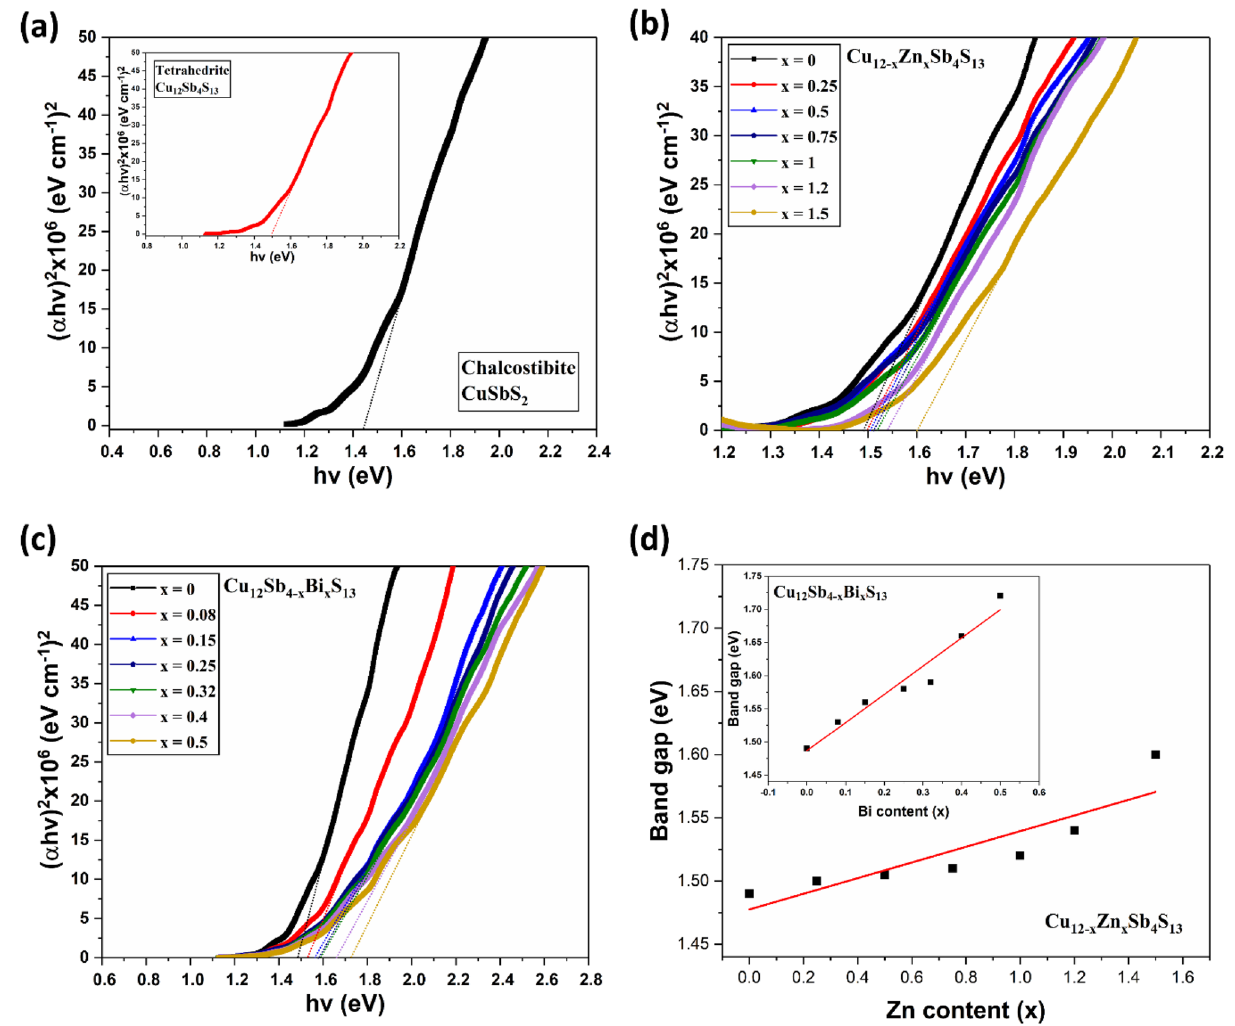
Figure 13. Estimation of optical band gap in Cu-Sb-S materials. Tauc plots for the ( a ) CuSbS 2 and Cu 12 Sb 4 S 13 (inset), ( b ) Cu 12−x Zn x Sb 4 S 13 (x = 0.25, 0.5, 0.75, 1, 1.2, 1.5) and ( c ) Cu 12 Sb 4−x Bi x S 13 (x = 0.08, 0.15, 0.25, 0.32, 0.4 and 0.5). ( d ) Variation of the band gap for Cu 12−x Zn x Sb 4 S 13 samples as a function x Zn , and the inset shows the variation of the band gap for Cu 12 Sb 4−x Bi x S 13 samples as a function x Bi